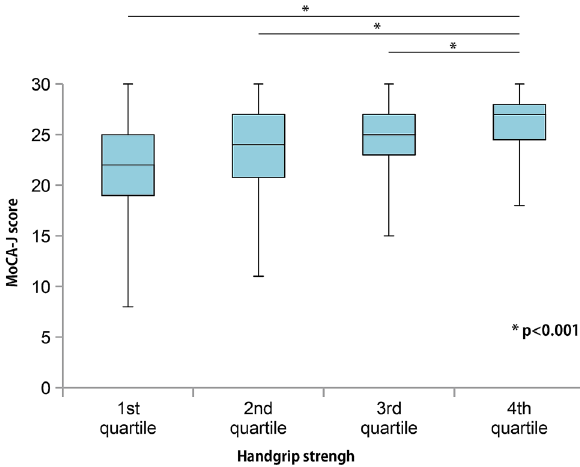
Figure 4. Montreal Cognitive Assessment-Japan (MoCA-J) scores for handgrip strength per quartile. Patients were divided into the following quartiles according to handgrip strength: first quartile [Q1], < 69.5% (19.5% in males and 12.5% in females); second quartile [Q2], ≥ 69.5% to < 91.0% (25.5 kg in males and 16.4% in females); third quartile [Q3], ≤ 91.0% to < 108.7% (30.4 kg in males and 19.6% in females); and fourth quartile (Q4), ≥ 108.7%. The median MoCA-J scores showed a significant upward trend from Q1 to Q4 (one-way ANOVA, p < 0.001). The MoCA-J score in Q4 was significantly higher than in the other quartiles (Tukey–Kramer post-hoc test; p <